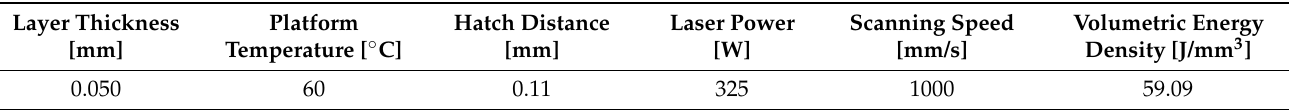
Table 2. Optimal combination of process